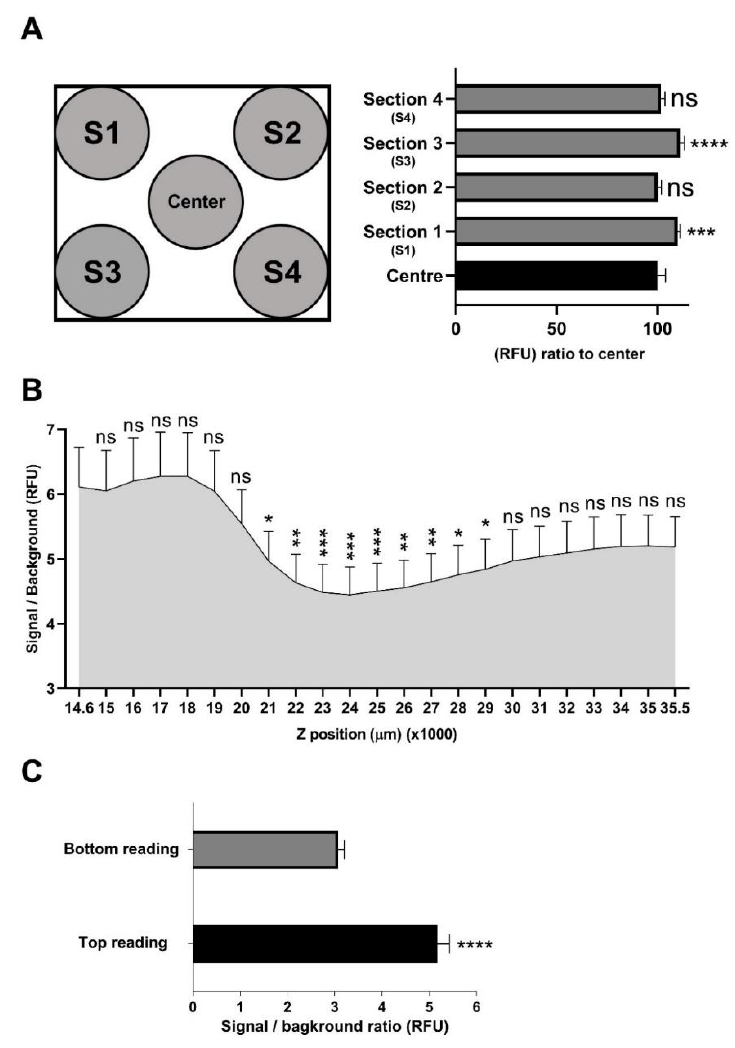
Figure 4. Signal distribution across a well using resazurin substrate. Data expressed as mean ± standard deviation from three independent assays with four replicates each. ( A ) Measurements taken from different sections within one Z-position inside a single well (multiple read, 2 × 2 with 250 µm distance from border of the read regions) using Tecan Spark 20 M multimode microplate reader: ns = not significant ( p > 0.05), *** p < 0.001, **** p < 0.0001, one-way ANOVA with Dunnett multiple comparisons test compared to reading from the centre. ( B ) Measurement at different Z-positions within a well ranging from 14600–35500 µm: ns = not significant ( p > 0.05), * p < 0.05, ** p < 0.01, *** p < 0.001, one-way ANOVA with Dunnett multiple comparisons test compared to reading at Z-position of 14,600 μm. ( C ) Top versus bottom reading: **** p < 0.0001, t -test with two-tailed comparison test.